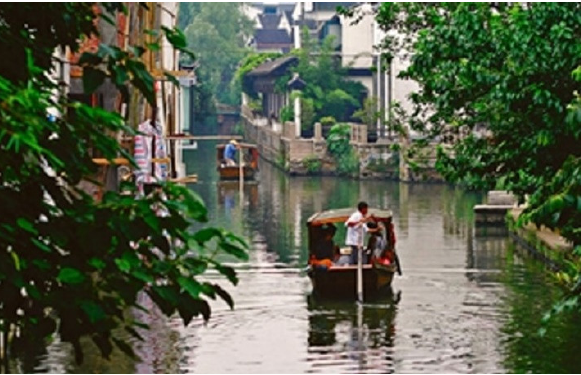
Figure 1. A typical picture of “small bridges, flowing water and homes” in central district of Su-